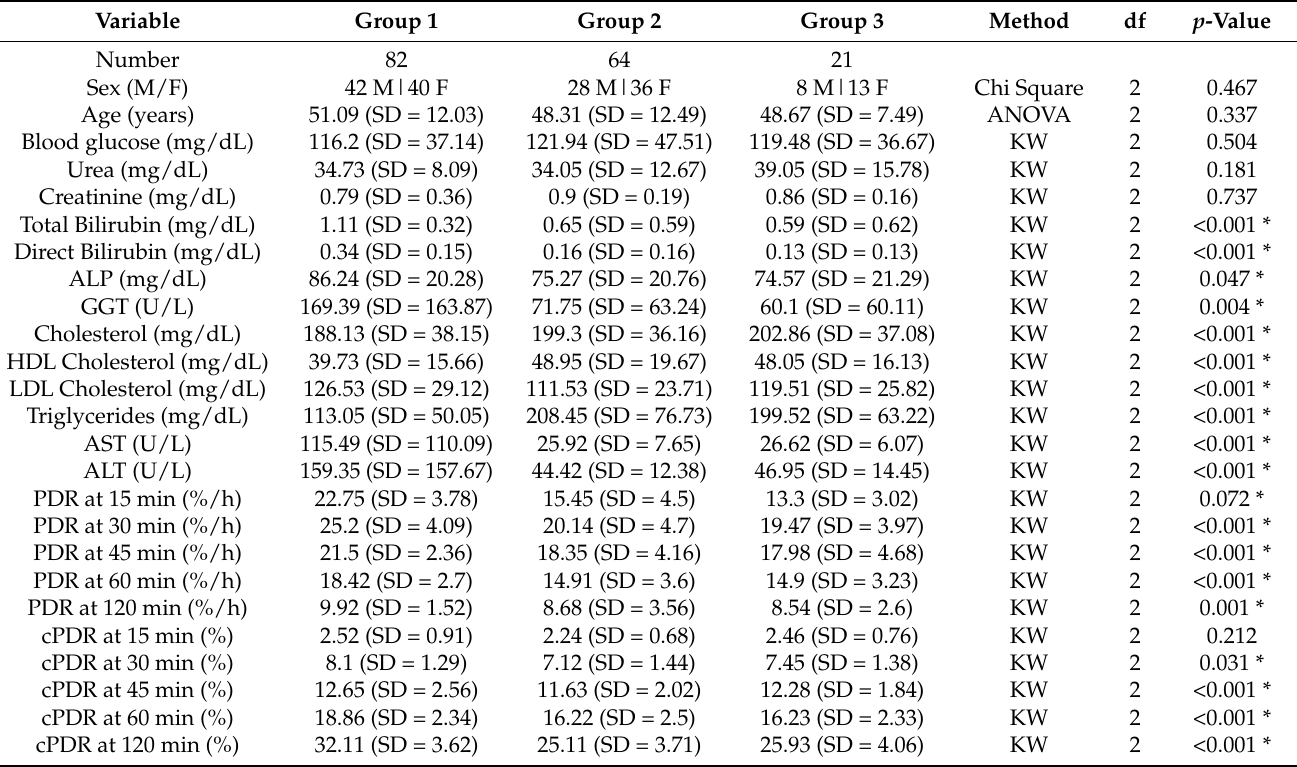
Table 2. Univariate Analysis.